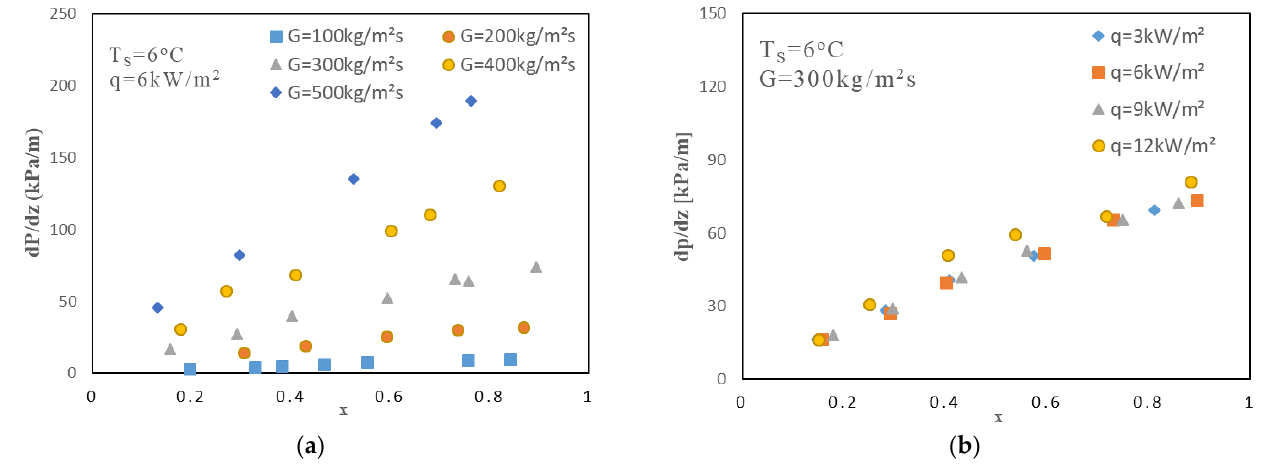
Figure 8. Effect of ( a ) mass flux and ( b ) heat flux on pressure drop.